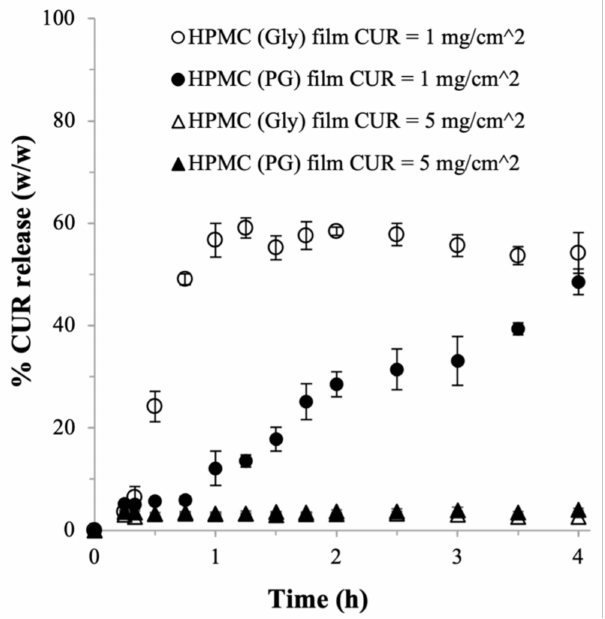
Figure 2. CUR release from HPMC (Gly) and HPMC (PG) films ( n = 6, error bars represent the standard